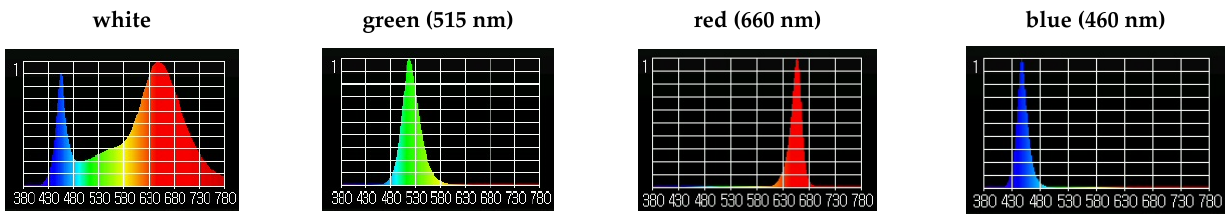
Figure 2. Graphs of LED light spectra used to evaluate the effects of their exposure (blue and various red spectra) on S. rebaudiana growth. Short-wave red (SR), long-wave red (LR), far red (FR), and blue (B) spectra are depicted.